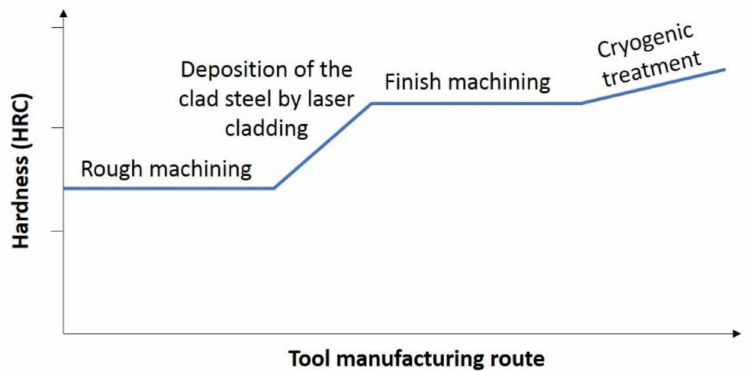
Figure 12. Proposed manufacturing route of forming